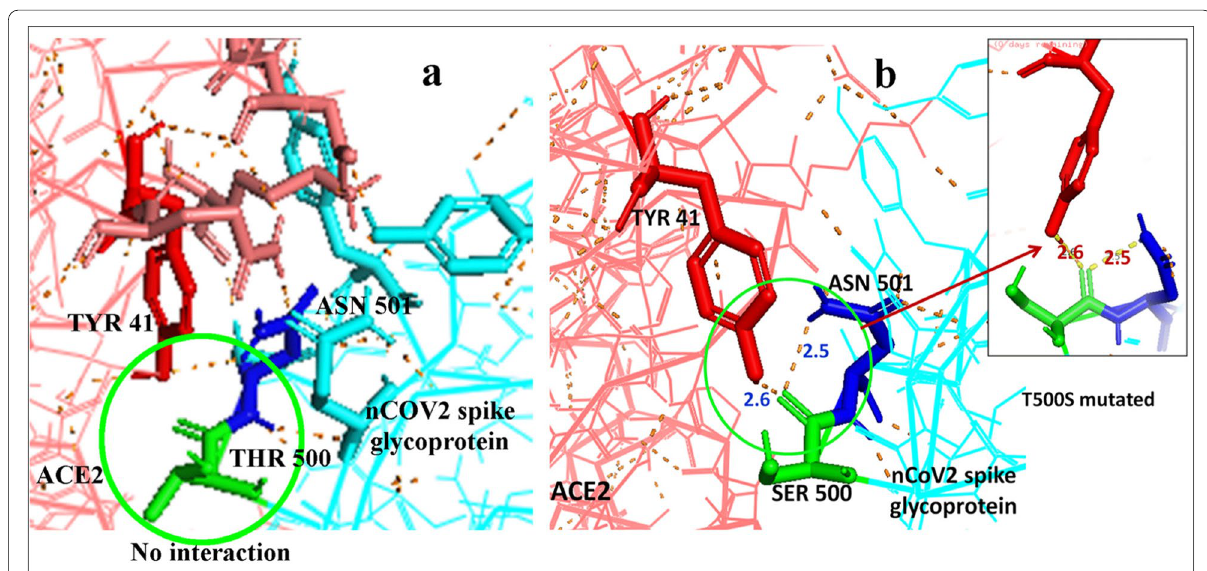
Fig. 2 Due to H-bond based close proximity of CUT4 with ACE2 (S Table 1), unmutated CUT4-THR500 did not showed and hydrogen bond with ACE2-TYR41 ( a ). T500S mutation only replaced the larger structure of THR with SER but mode it convenient to form H-bond with ACE2-TYR41 due to presence of same –OH group ( b ) and stabilized the ACE2-CUT4 mutant binding. Finally confirms the displacement of nCOV2 spike glycoprotein